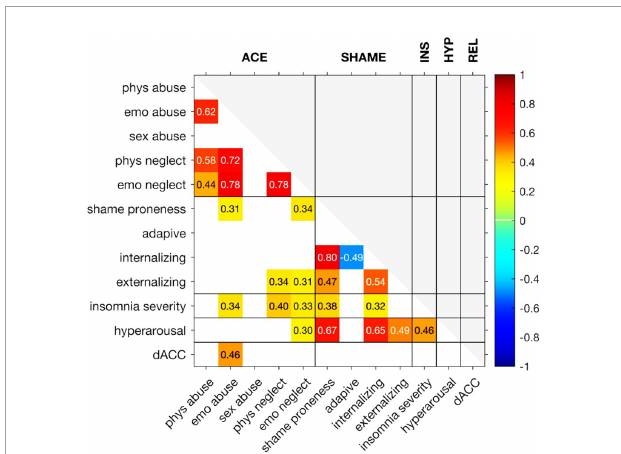
FIGURE1 Correlation between observed variables. The color indicates the strength of the correlation. Only correlations with p -value below 0.05 are shown. Abbreviations from left upwards to left downwards: physical abuse, emotional abuse, sexual abuse, physical neglect, emotional neglect, shame proneness, adaptive shame coping, internalizing shame coping, externalizing shame coping, insomnia severity, hyperarousal, and dorsal anterior cingulate cortex. Abbreviations from left upward to right upward: adverse childhood experiences (ACEs), Shame, Insomnia Severity (INS), Hyperarousal (HYP), reliving shameful experiences